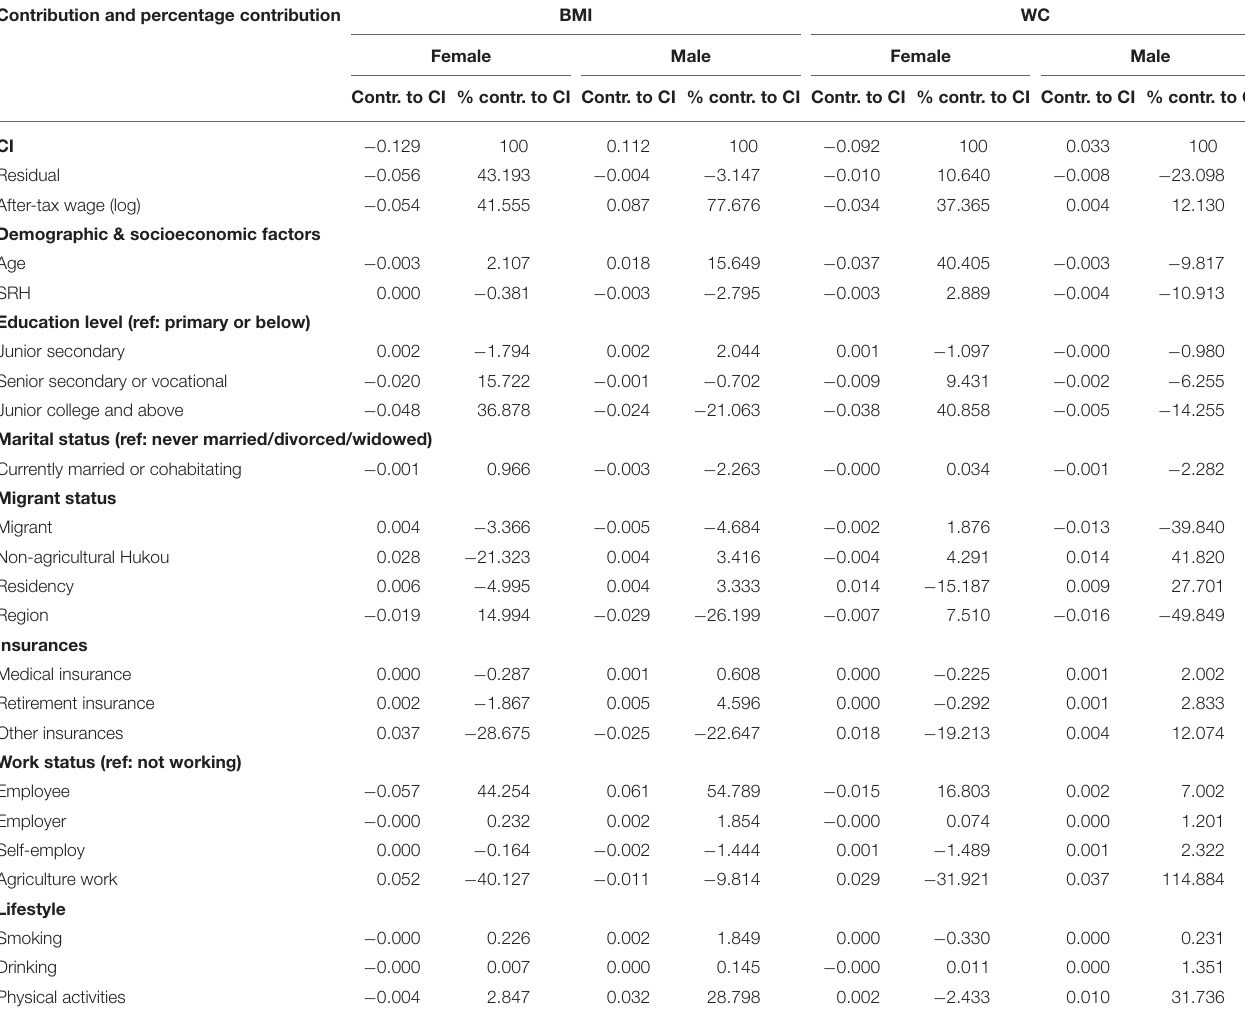
TABLE 3 | Detailed contributions to inequality in the probability of being obese by demographic and socioeconomic factors, and female and male labor forces. Contribution and percentage